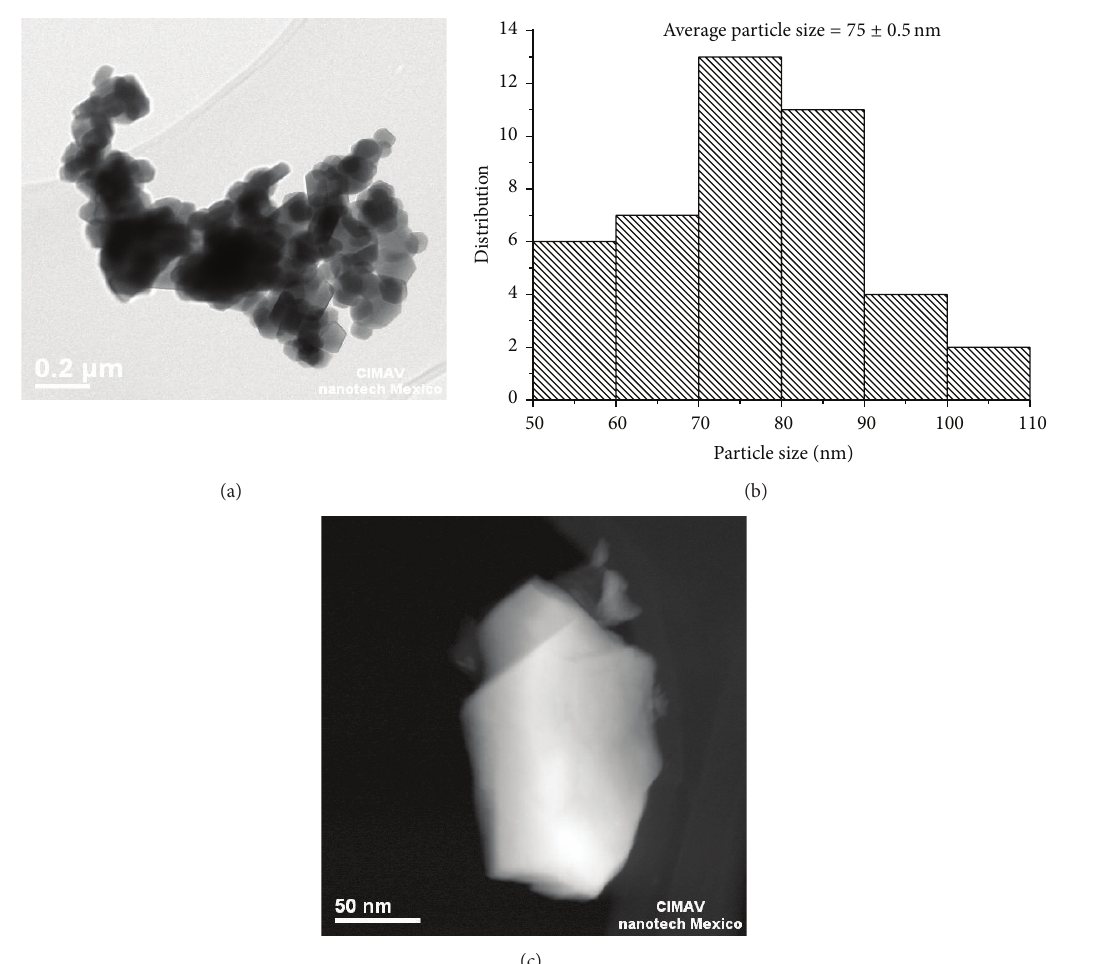
Figure 6: Micrographs of HRTEM of the nano-bimetallic Rh-Pd. (a) Sphero-hexagonal shapes, (b) average-size distribution of particles ( ∼ 75nm), and (c) grain of the bimetallic Rh-Pd of ∼